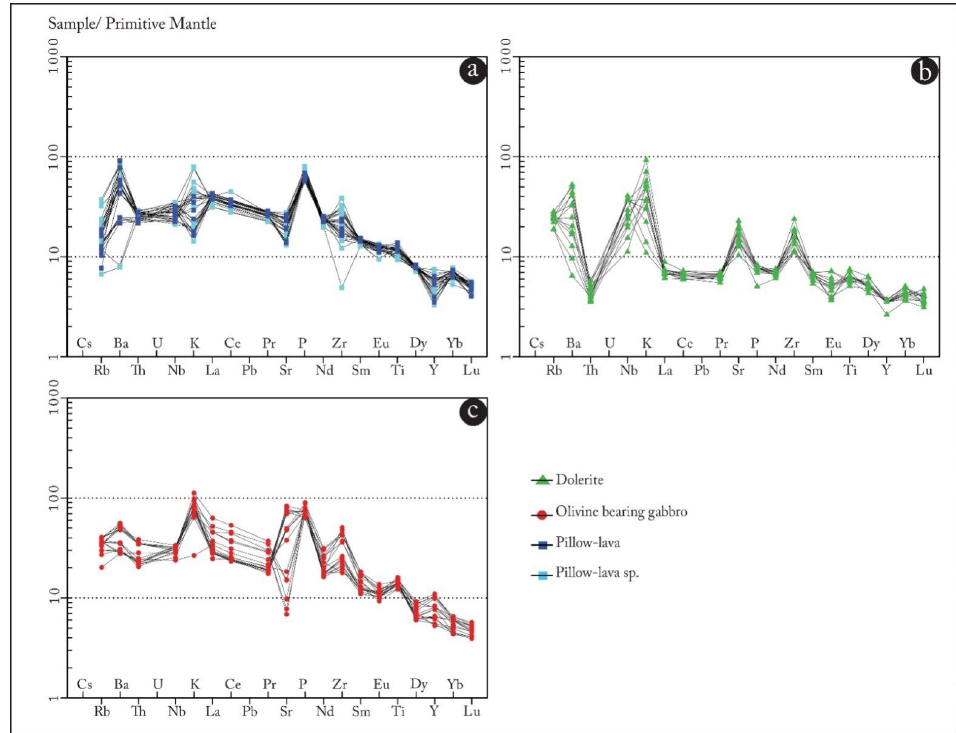
Figure 24. Multielement diagrams normalized to primitive mantle [67] for magmatic rocks of NNE Achemmach. ( a ): Pillow-lavas, ( b ): dolerites, ( c ): Olivine-bearing gabbros. Minerals 2022 , 12 , x FOR PEER REVIEW